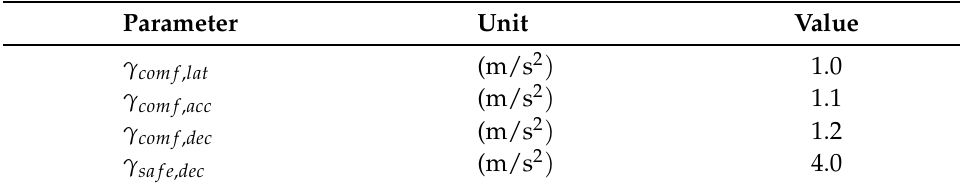
Table 4. Acceleration limits used in the validation experiments.